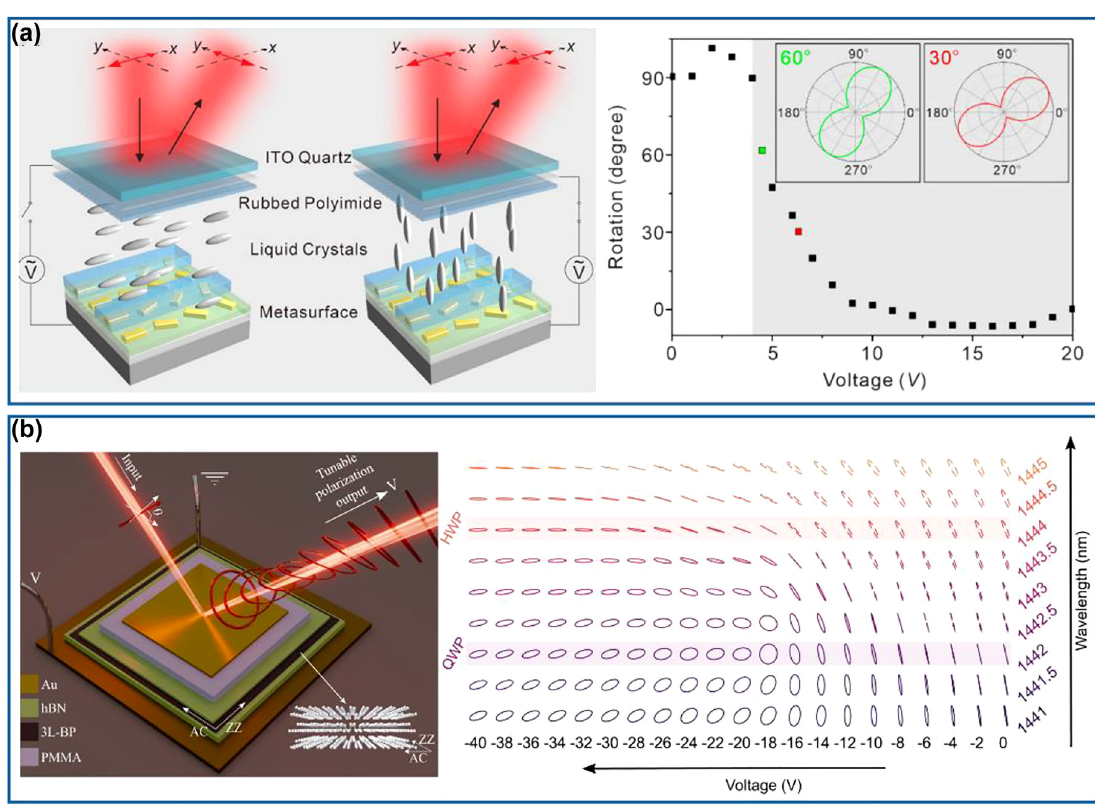
Figure 10: Electrically-triggered dynamic meta-waveplates. (a) Left panel: working principle of the electrically tunable metasurface for active polarization conversion by combining both the geometric from Au antennas and tunable propagation phase supplied by an LC layer. Right panel: measured rotation angle of the linear polarization as a function of the applied voltage. Reprinted from Ref. [132]. (b) Left panel: schematic of electrically tunable polarization conversion with an FP cavity incorporating TLBP with a larger tunability of birefringence. Right panel: measured re fl ected polarization ellipse for selected voltages and nine different wavelengths. Reprinted from Ref.